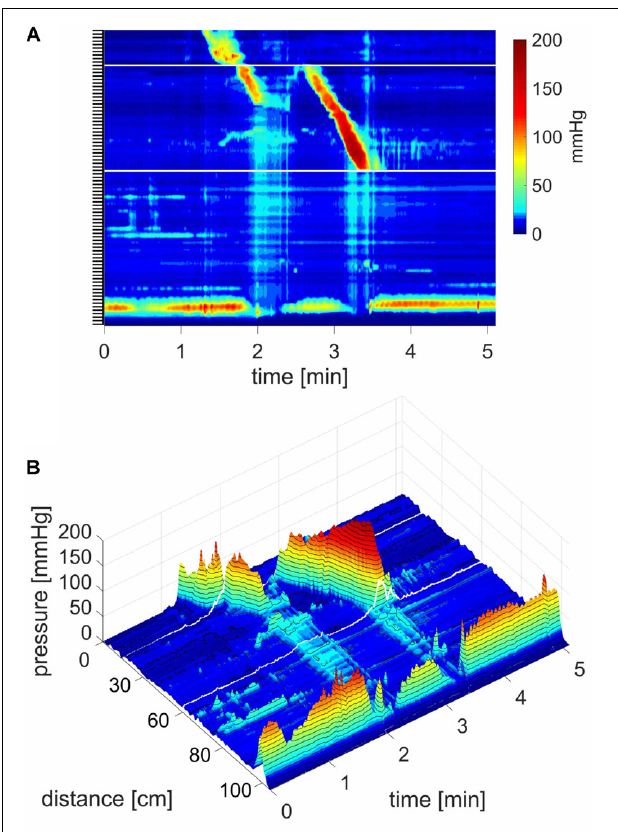
FIGURE 2 | Two proximal High Amplitude Pressure Waves (HAPWs) that develop into SPWs: HAPW-SPWs in response to a meal. (A) HAPWs that turn into SPWs with full anal sphincter relaxation. The image shows activity in 100 cm of the colon (position of 84 sensors are shown at the left side of the figure). The activity was observed 12 min after meal intake. The first HAPW-SPW was associated with liquid outflow, the second with liquid and gas expulsion. (B) 3D representation of (A)